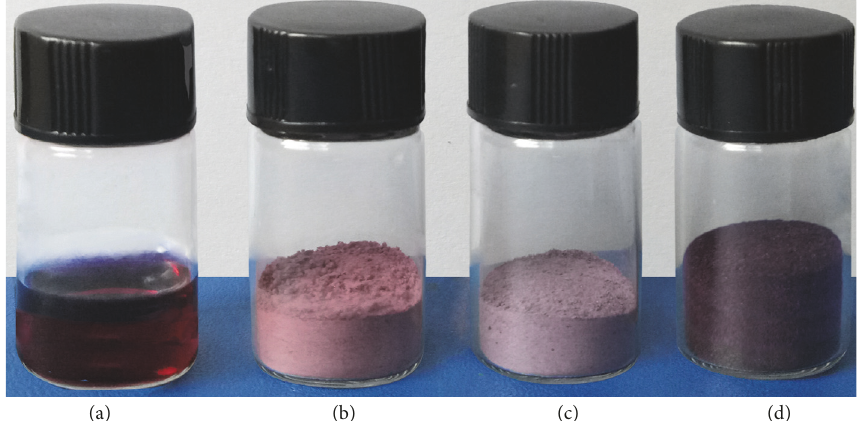
Figure 7: Photograph of AuNPs/dextran solution (a), spray drying (b), coagulation (c), and centrifugation (d) of AuNPs powders.